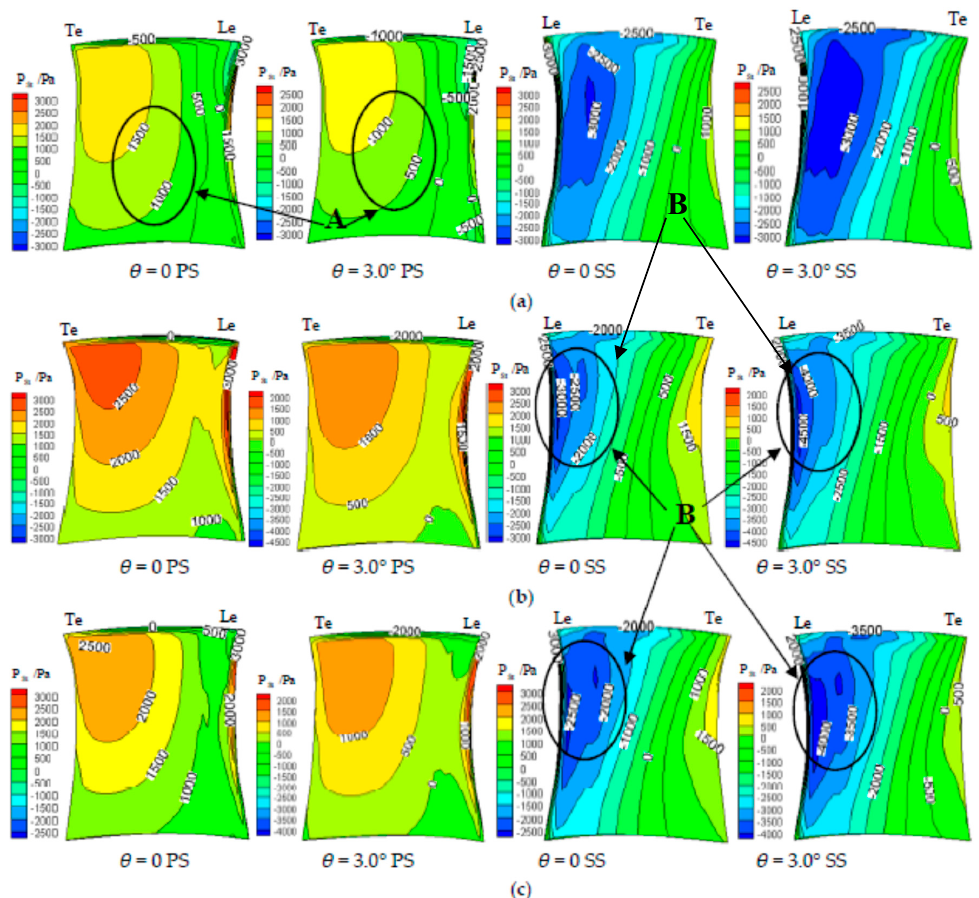
Figure 11. Distribution of the relative static pressure at the blade surfaces. ( a ) β = 29 ◦ ; ( b ) β = 32 ◦ ; ( c ) β = 35 ◦